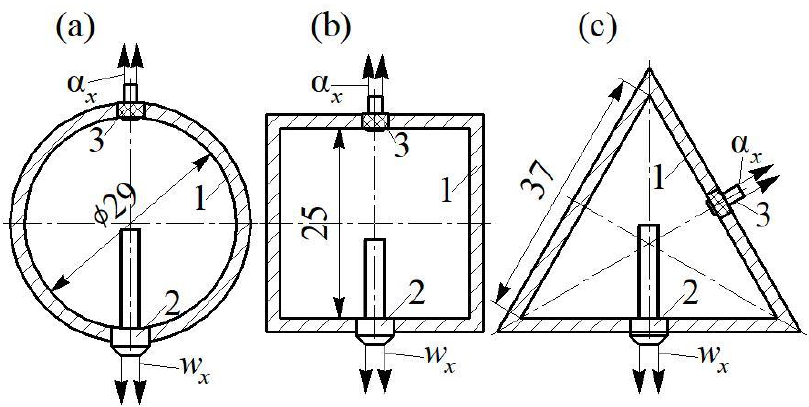
Figure 3. Pipe cross-sections with main dimensions and sensor installation locations: ( а ) round; ( b ) square; ( c ) equiangular triangle.